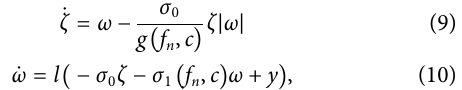
FIGURE3| LimitSurfacewithmaximumtangential ( f t load that the friction can withstand, with the given grip force f n .